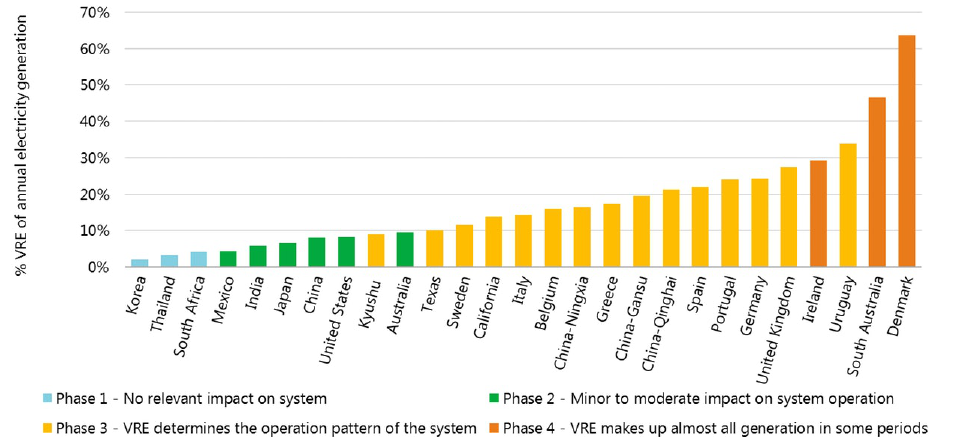
Figure 1. Variable renewable energy (VRE) level of penetration registered in 2018 [3]. Source: IEA (2019). Status of Power System Transformation 2019. All rights